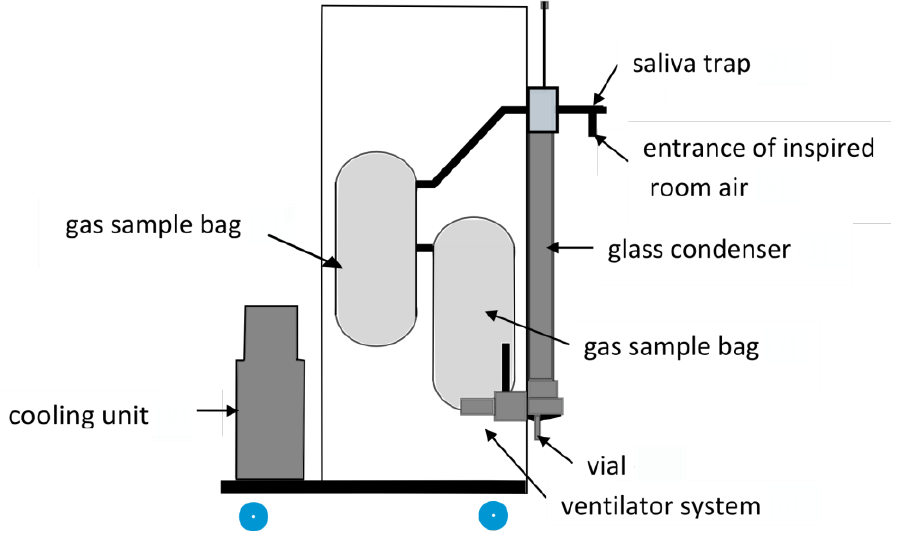
Figure 9. Diagram of the glass closed condenser. Modified from